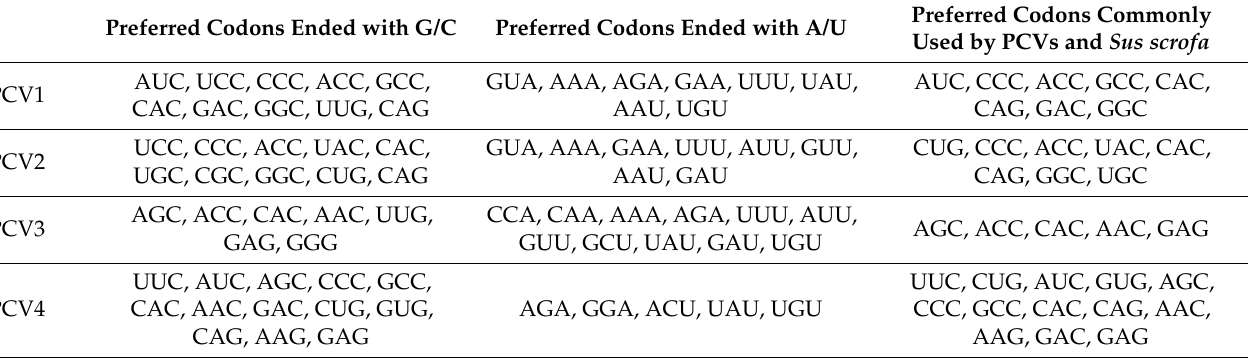
Table 3. The preferred codons used by PCVs and the ones commonly used by PCVs and Sus scrofa. Preferred Codons Commonly Used by PCVs and Sus scrofa Preferred Codons Ended with G/C Preferred Codons Ended with A/U